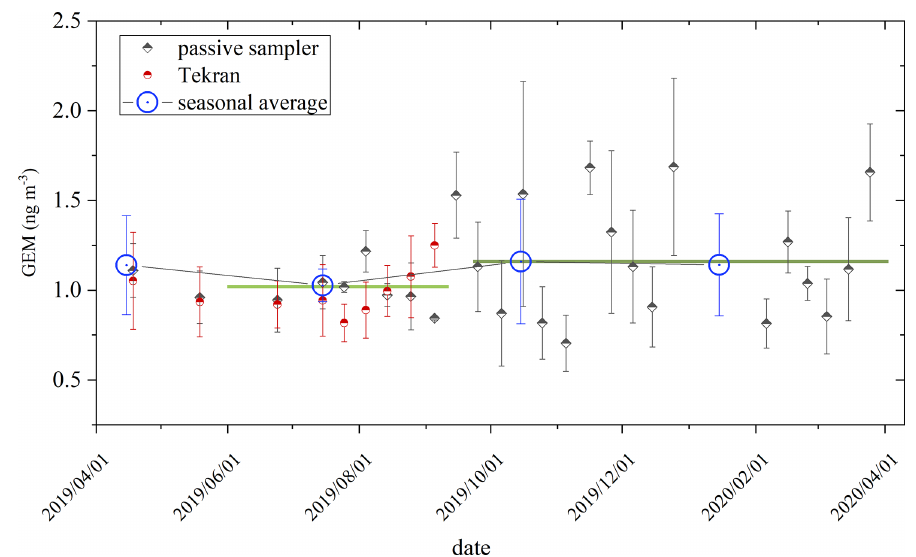
Figure 3. GEM concentrations obtained through passive samplers throughout the year. The black squares represent the atmospheric Hg concentrations obtained by passive sampling, and the upper and lower error lines are the standard errors of the passive samples monitored during the same time period. The red dots represent the GEM concentrations obtained through the Tekran instrument. The green horizontal line indicates the average of the atmospheric mercury concentrations during this